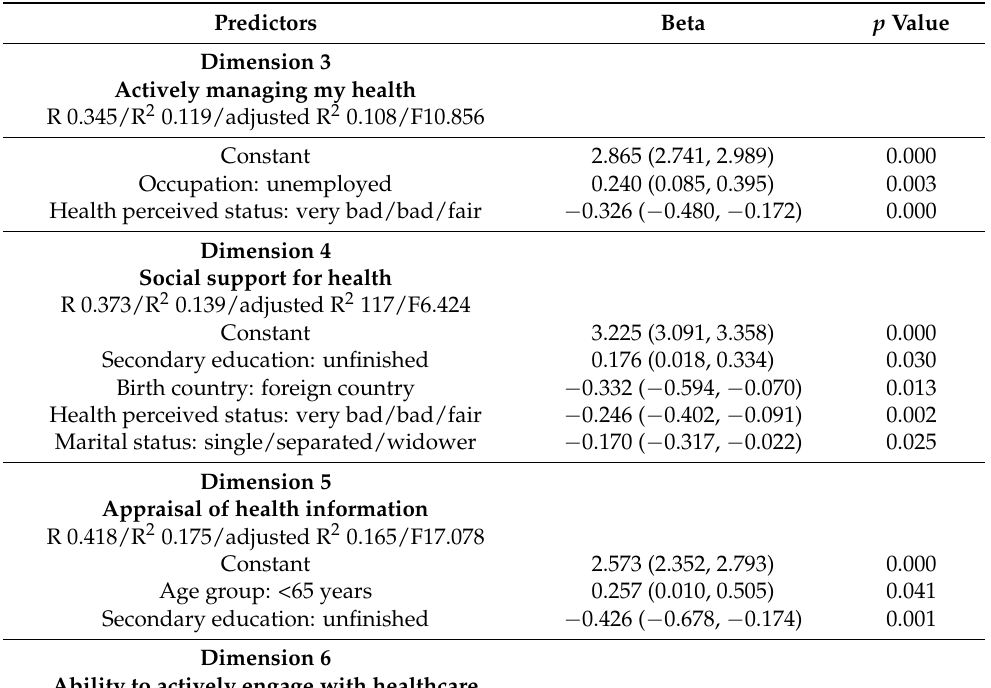
Table 2. Results of multiple regression analysis: positive and negative predictors of health